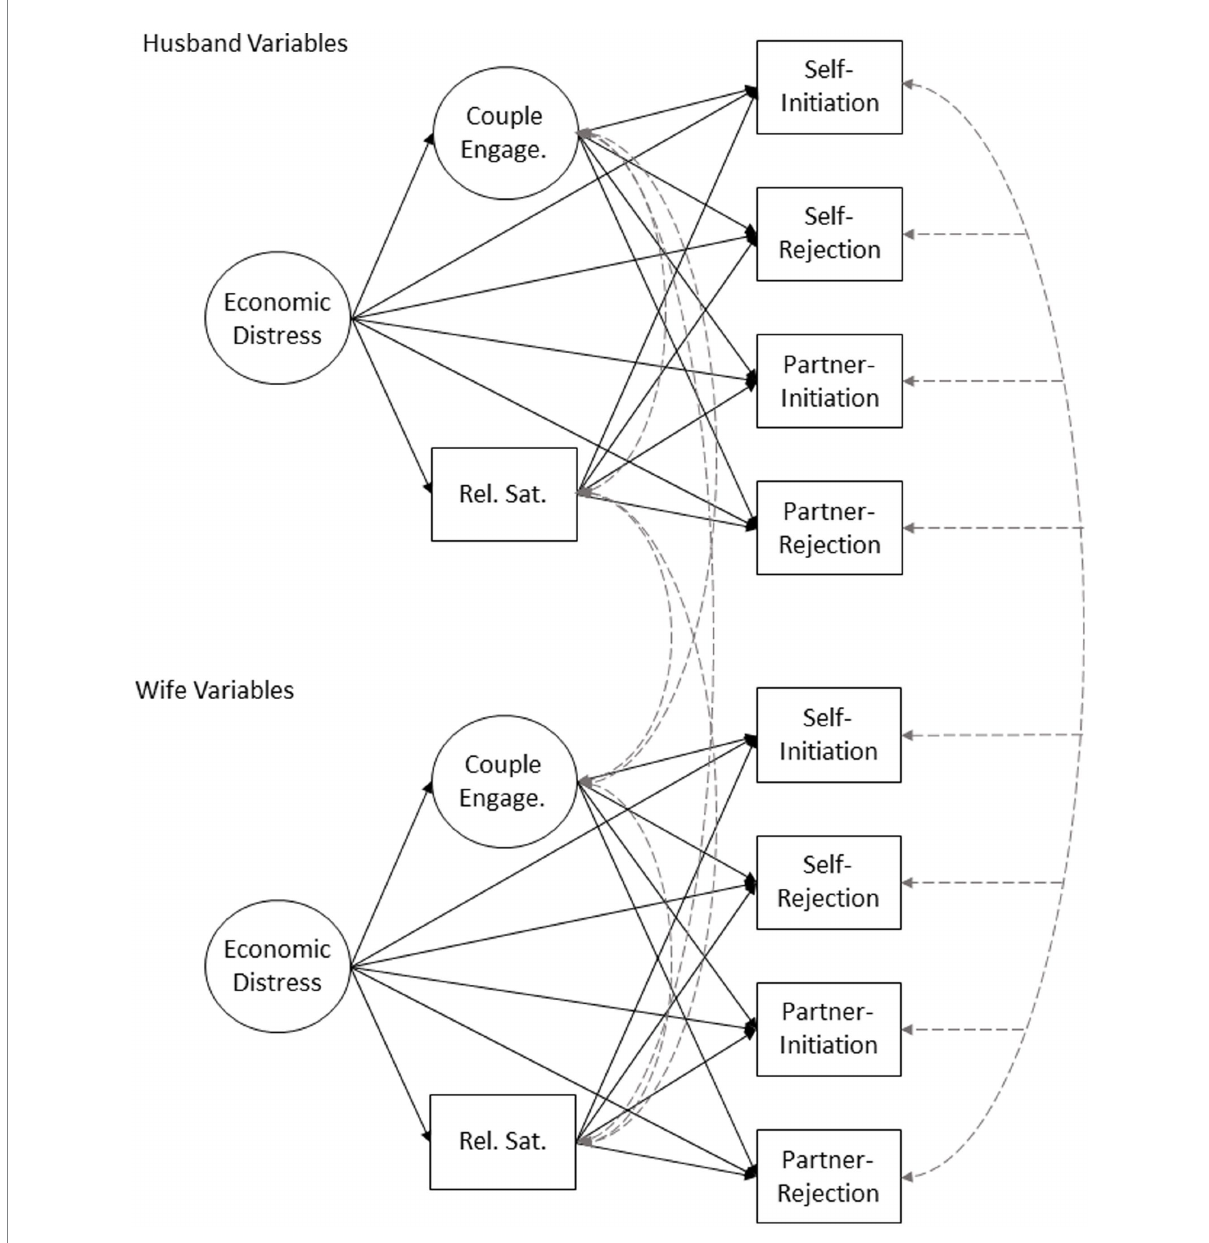
FIGURE 2 Specified model. Correlations are shown as dotted lines. For ease of reading, co-variates are not shown. “Self-” indicates reports on self-behavior, and “partner-” indicates reports on partner